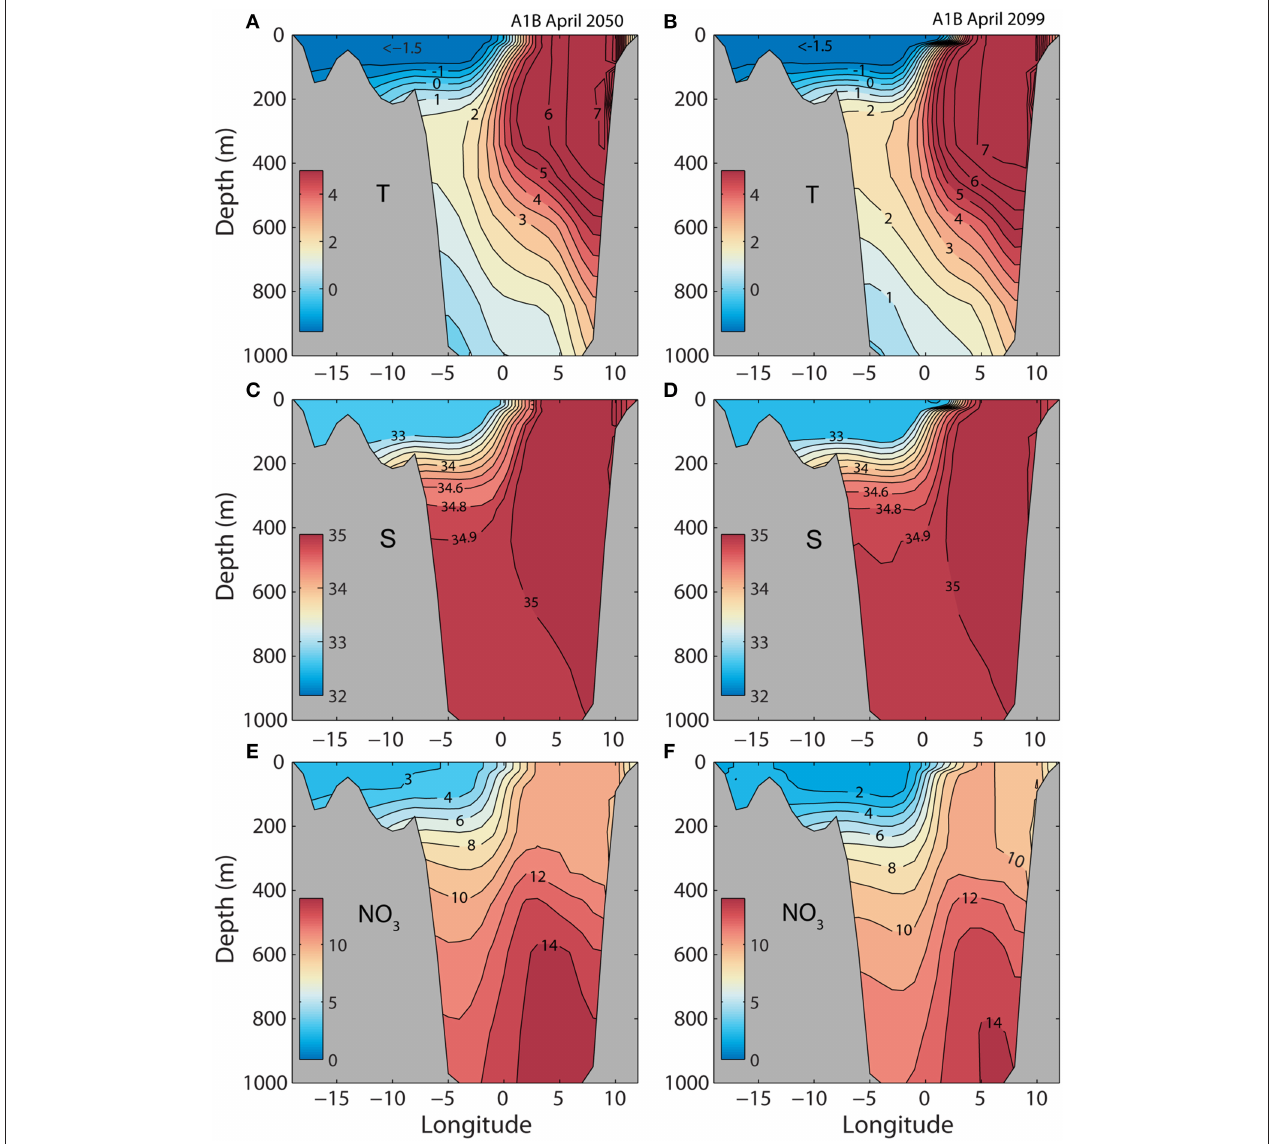
FIGURE 6 | Simulated monthly mean temperature ( ◦ C), salinity (psu), and nitrate (mmol N m − 3 ) for April along section across the Fram Strait (see Figure 2). Forced by a A1B scenario. (A,C,E) April 13 in 2050. (B,D,F) August 16 in